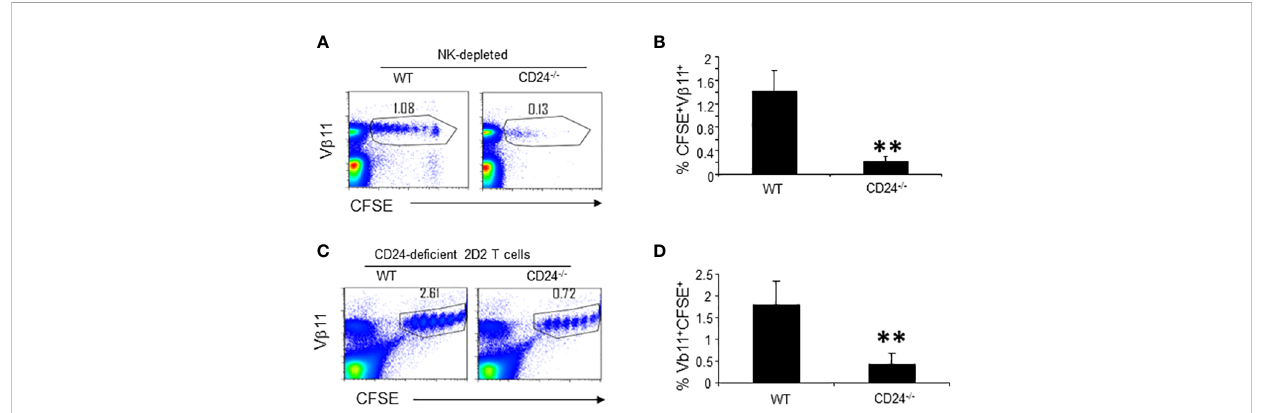
Since CD24 expression on T and B cells are not necessary for optimal proliferation of T cells (Figure 5), we hypothesized that CD24 on DC was necessary for optimal expansion of T cells. To test if CD24 expression on DC is required for optimal proliferation of 2D2 T cells, DC CD24TG mice were crossed with CD24 -/- mice for two generations and we generated mice with CD24 expression only on DC (DC CD24 CD24 -/- mice) (30). In these mice, all CD11c + cells